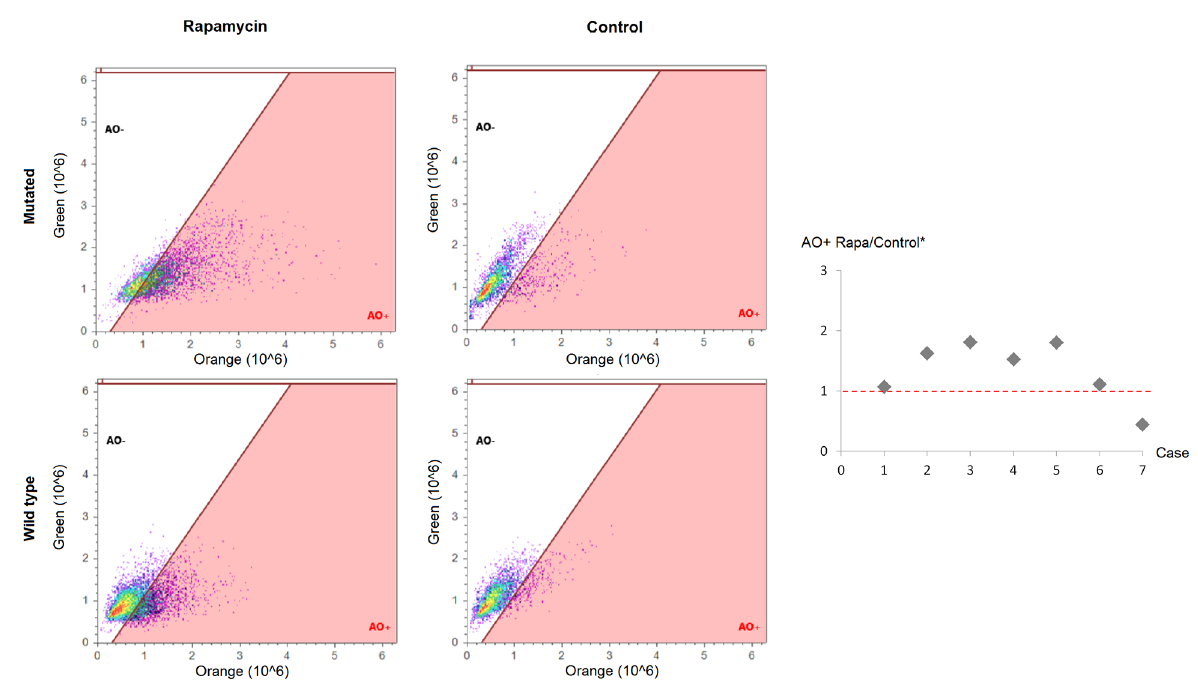
Figure 3 ‒ Autophagy analyses. Cells were incubated with acridine orange solution and submitted to Attune Cytometer analysis. Percentage of acridine orange positive (AO+) and acridine orange negative (AO-) cells of representative samples is shown on the left. The ratio of autophagic cells in wells treated and untreated with rapamycin for each case is shown in the right panel (cases 1-5 are mutated and cases 6-7 are wild type). There was an increase in the number of autophagic cells after rapamycin treatment in mutated cells